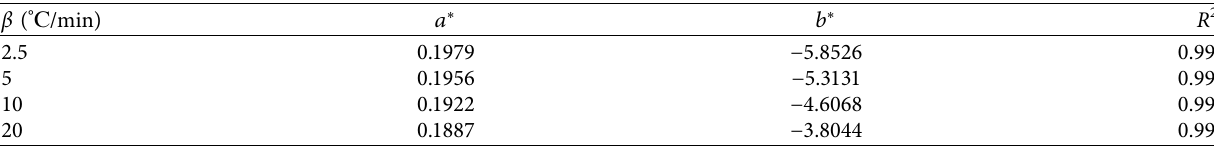
Table 4: Values of the compensation effect parameters of thermal decomposition of the p-EGF:AA copolymer at four different heating